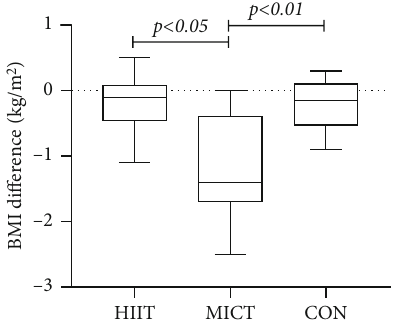
Figure 4: Comparison of BMI di ff erences in each group after the